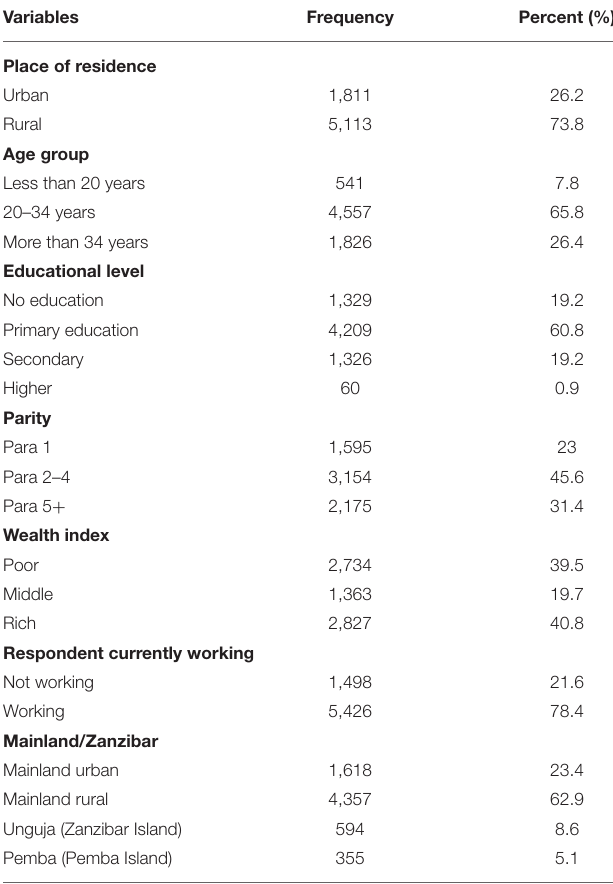
TABLE 1 | Socio-demographic